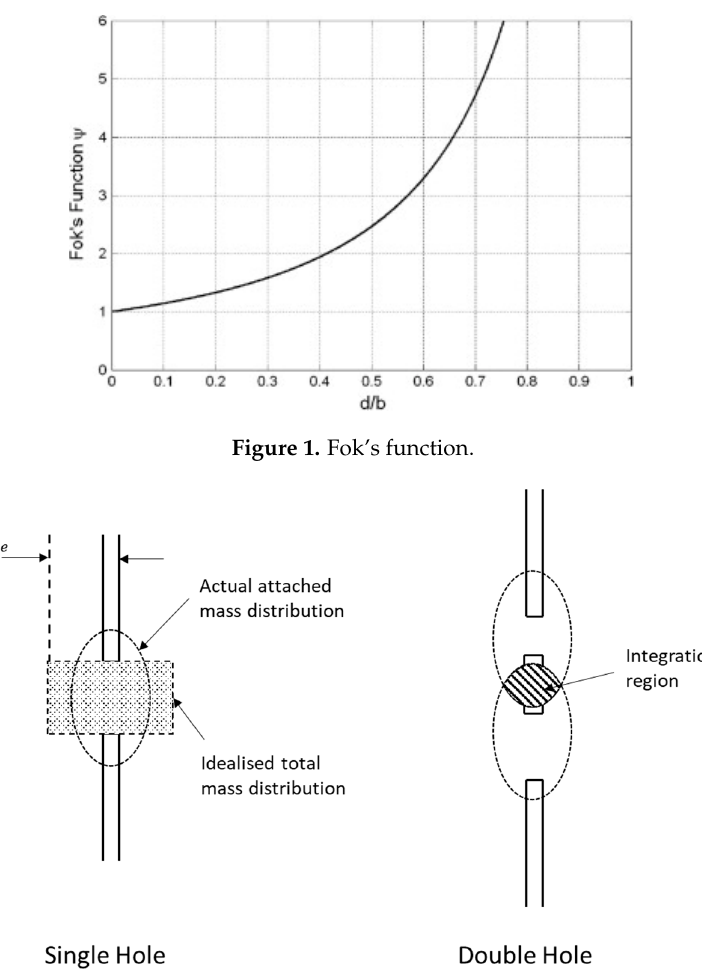
Figure 2. Illustration of the Hole–Hole interaction effect, redrawn, based upon Melling [10].